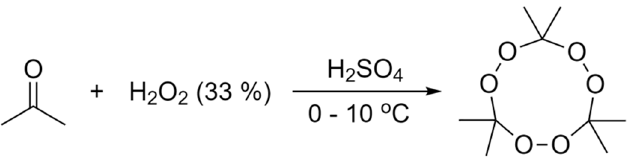
Figure 5. TATP synthesis route used in this study.